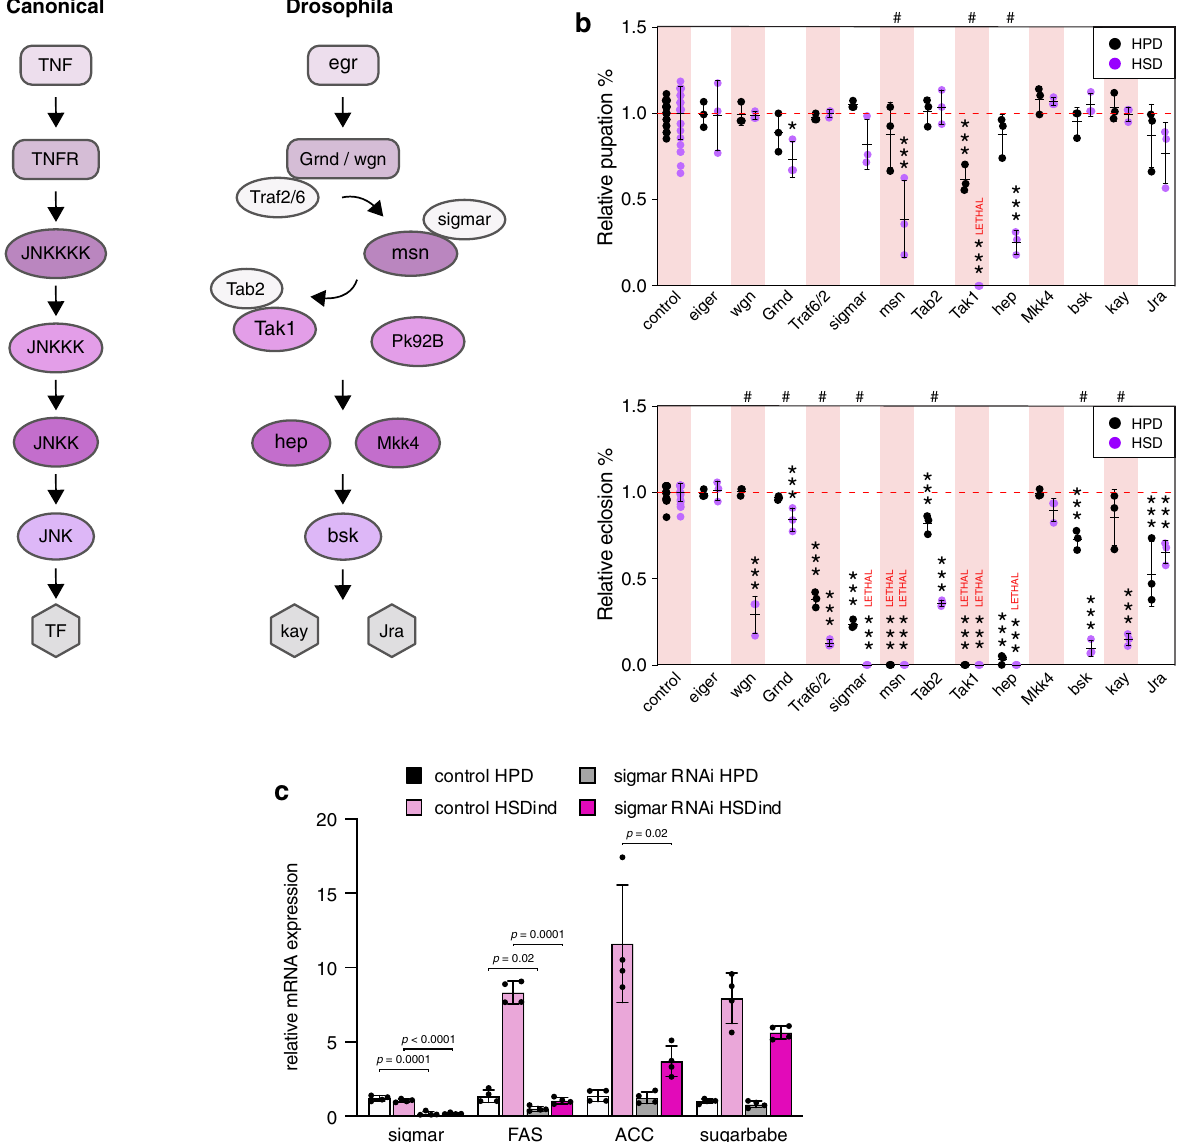
Fig. 6 JNK signalling is required for dietary sugar tolerance and DNL. a JNK pathway is well-conserved in Drosophila . b Knockdown of wengen ( wgn ), grindelwald ( Grnd ), TNF-receptor-associated factor 6 ( Traf2/6 ), sigmar , misshapen , TAK1-associated binding protein 2 ( Tab2 ), TGF- β activated kinase 1 ( Tak1 ), hemipterous ( hep ), basket ( bsk ) and kayak ( kay ), all lead to a signi fi cantly reduced survival on HSD. # = signi fi cantly lower survival on HSD vs. HPD (within genotype). n = minimum of 3 vials (each with 30 larvae) per diet and genotype. Data for control animals ( Tub-GAL4 > kk control 60100, Tub-GAL4 > GD control 6000, Tub-GAL4 > Trip control 36303, Ubi-GAL4 > kk control 60100 and Ubi-GAL4 > Trip control 36303), is pooled in the fi gure. Statistical signi fi cances for each knockdown were however calculated against their respective library control line. Statistical signi fi cances were calculated using the two-way ANOVA in conjunction with Dunnett ’ s multiple comparisons test (by genotype) and with Š ídák ’ s multiple comparisons test (by diet). * p < 0.05, ** p < 0.01, *** p < 0.001 (Dunnett ’ s multiple comparisons test), # p < 0.05 ( Š ídák ’ s multiple comparisons test). See Source Data fi le for exact p -values. c Whole-body expression of FAS and ACC in control and sigmar RNAi ( Tub-GAL4 >) larvae after transient (8 h) HSD feeding (HSDind), n = 4 ( fi ve second- instar larvae per sample) per diet and genotype. Statistical signi fi cances were calculated using an unpaired Student ’ s t test assuming unequal variances. Data are presented as mean values + / − SD. Source data are provided as a Source Data Tailless is required in the fat body for dietary sugar tolerance . Next, we focused on the role of tailless in dietary sugar tolerance.